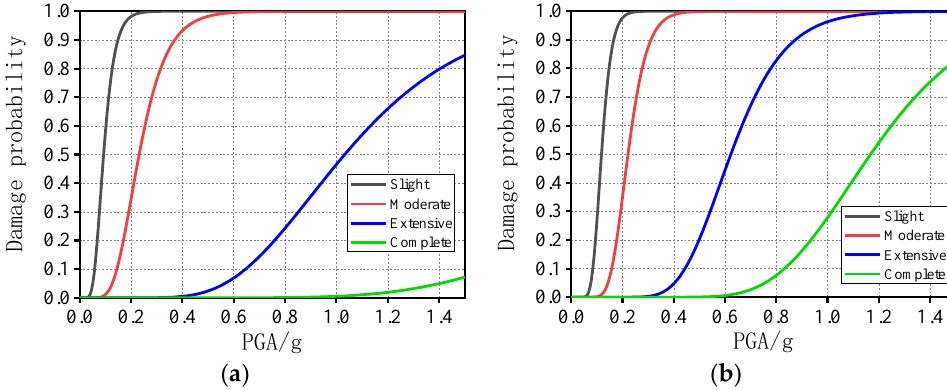
1.40.0 0.0 0.2 0.4 0.6 0.8 1.0 1.2